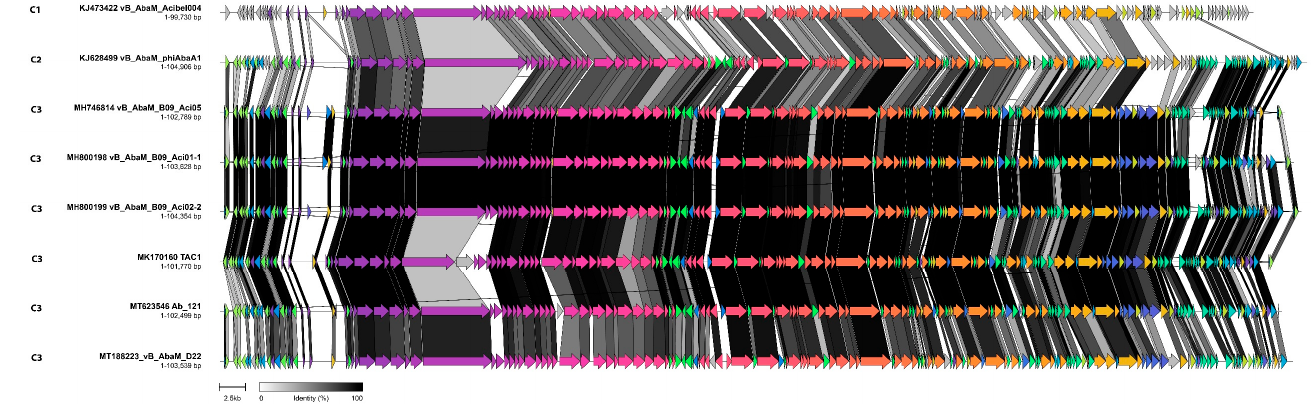
Figure 6. Comparative genome alignment of Acinetobacter phages comprising cluster C. Phage genomes are presented alongside their designated sub-cluster, accession number, name and genome length. Coding sequences are represented by arrows, coloured to reflect homologous groups identified by Clinker, and are linked by grey bars shaded to represent the percentage amino acid identity, as indicated in the legend.